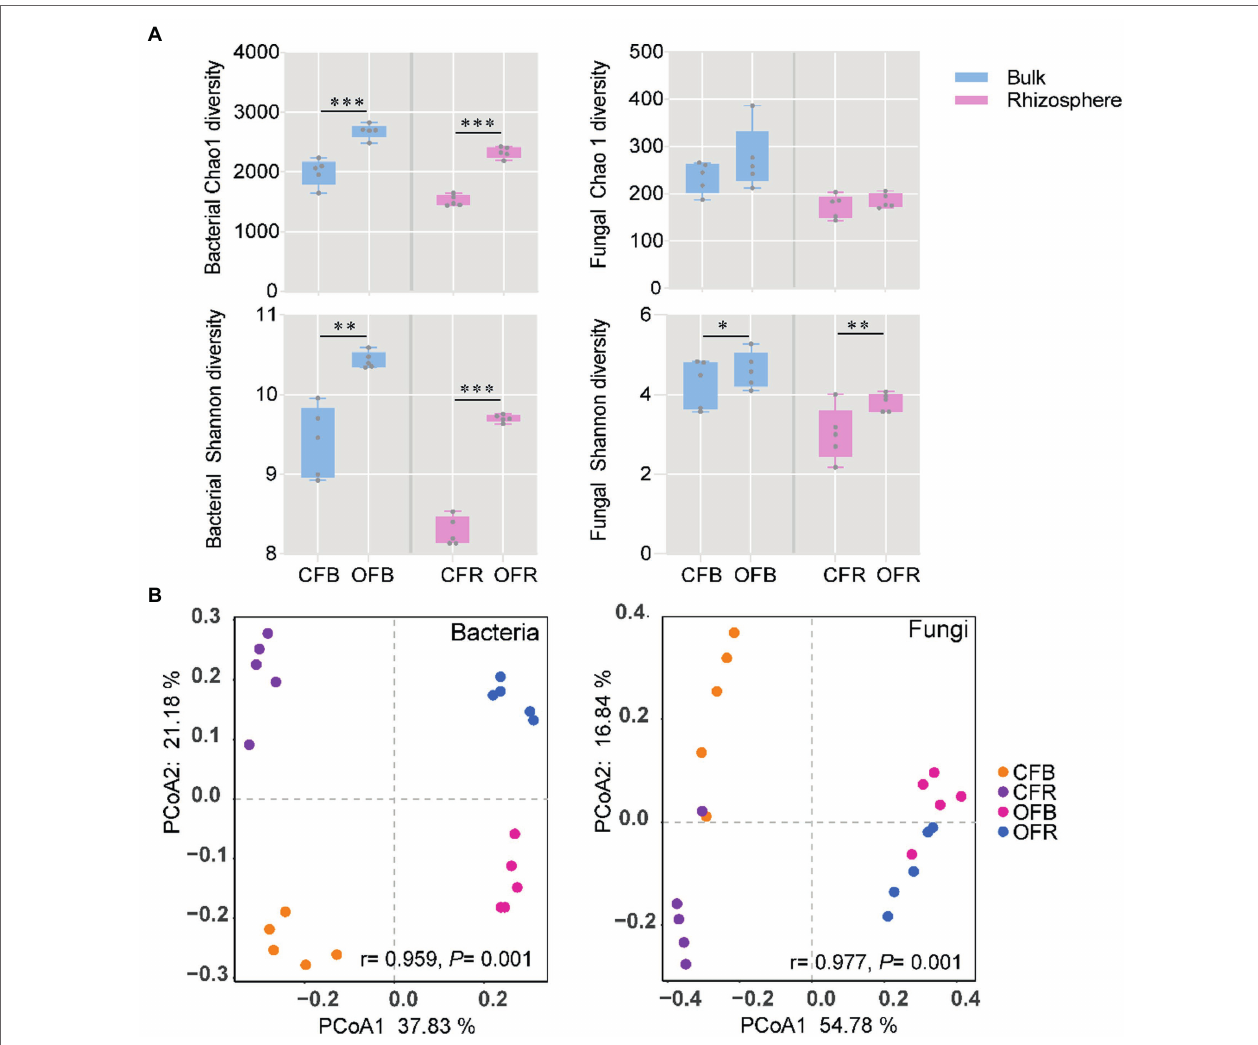
FIGURE 2 | Bacterial and fungal community diversity. (A) Boxplot of bacterial and fungal richness and diversity index. (B) PCoA ordinations of the bacterial and fungal community compositions based on the Bray–Curtis distance metric for all soil samples. CFB, chemical fertilizer-amended bulk soil; CFR, chemical fertilizer- amended rhizosphere soil; OFB, organic fertilizer-amended bulk soil; and OFR, organic fertilizer-amended rhizosphere soil. * p < 0.05; ** p < 0.01; and *** p <